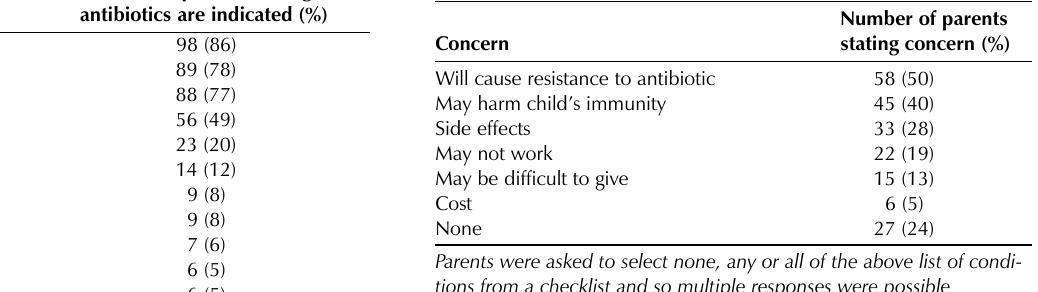
Usual setting where child brought for care PED